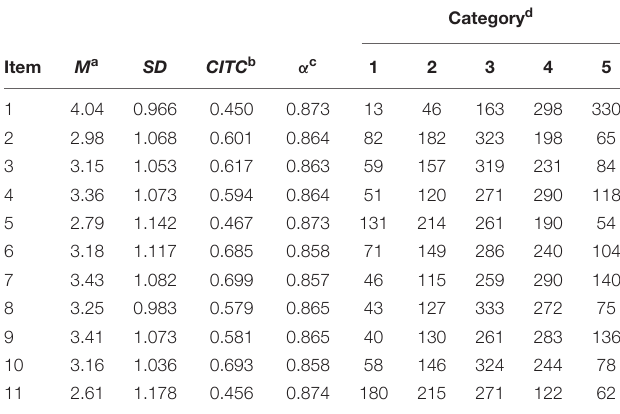
TABLE 7 | Classical item analysis of self-reflectiveness scale ( α = 0.88, CI 95 = 0.86,